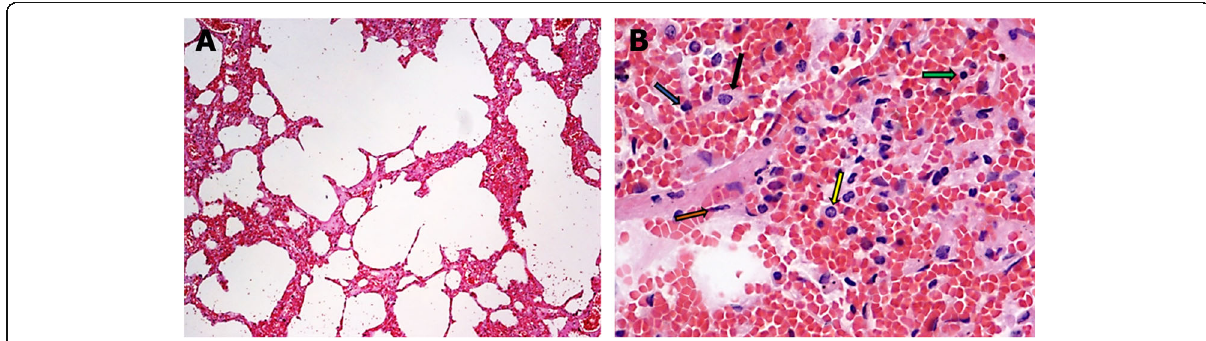
Fig. 1 Histological changes in case 1. a Exudative phase of acute interstitial pneumonia (hematoxylin and eosin stain, × 100). b Detail of an alveolar septum with edema, hemorrhage and inflammatory cell infiltrations (green arrow: lymphocyte; yellow arrow: macrophage; brown arrow: fibroblast; blue arrow: polymorphonuclear leukocyte; black arrow: type II hyperplastic pneumocyte) (hematoxylin and eosin stain, ×